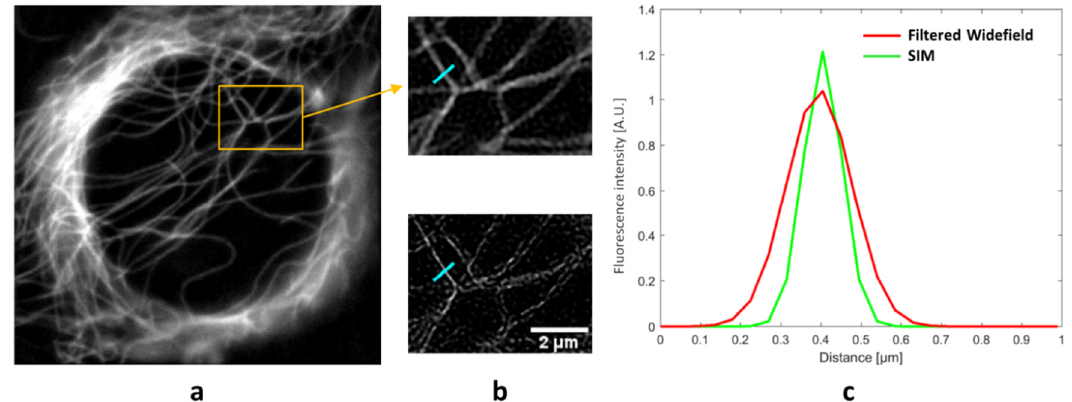
Figure 4. Fluorescence image of a 3T3 fibroblast incubated with Tubulin Tracker™ Green (250 nM for 20 min): ( a ) wide-field microscopy with Wiener filter, ( b ) comparison of filtered wide-field image and SIM for a selected field, and ( c ) line scan with Gaussian fit over a marked range of 0.8 µm for filtered wide-field and SIM (“full result”). Excitation wavelength: λ 0 = 488 nm; detection range: λ D ≥ 515 nm; Plan Neofluar 40×/1.30 oil immersion objective lens.